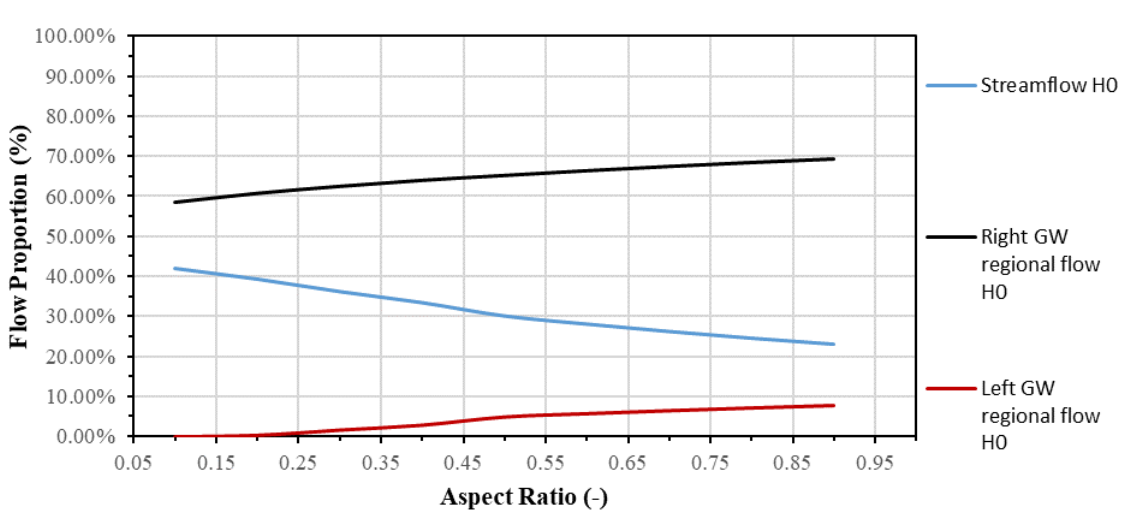
Figure A1. Fractions of water feeding the pumping WELL as a function of the aspect ratio for a variable pumping flow (Q = 0.01 *Ar).